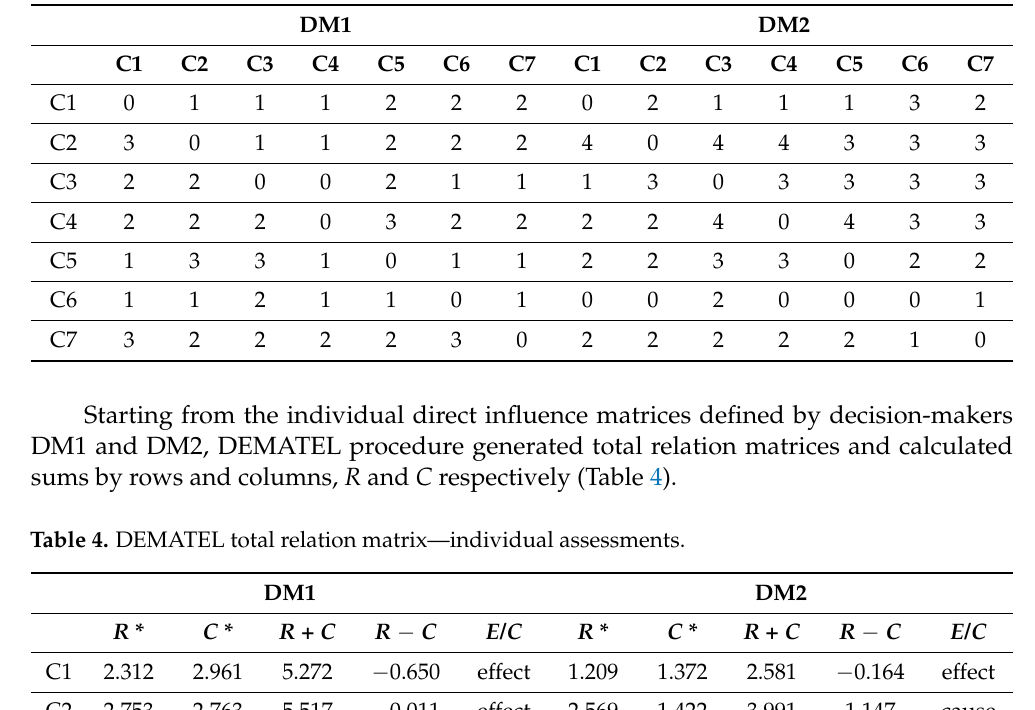
Table 3. DEMATEL direct influence matrix—individual assessments.